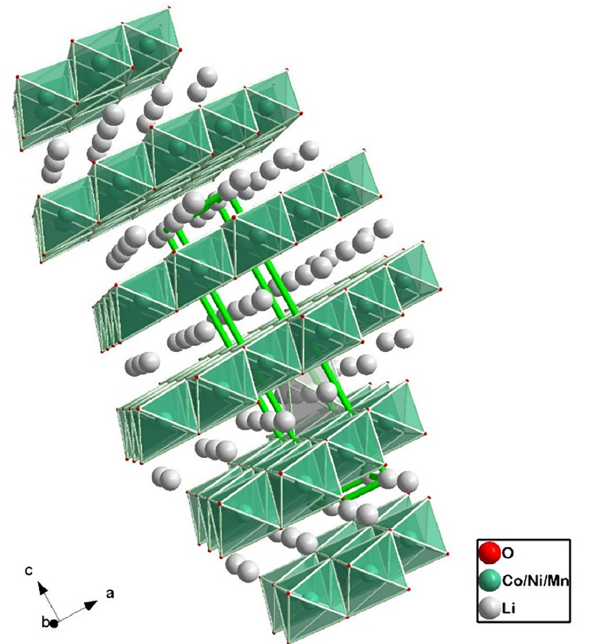
Figure 7. Rhombohedral (layered) structure for NMC622. Space group: R-3m.